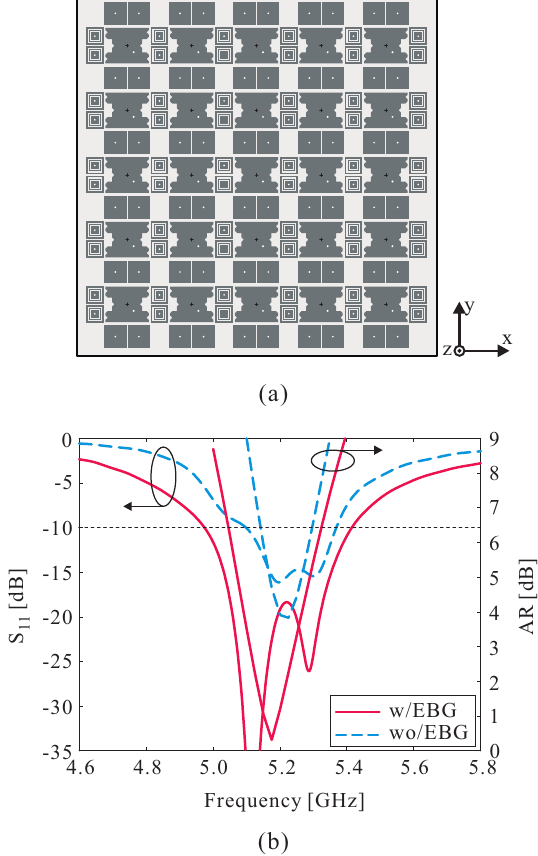
Figure 7. ( a ) 5 × 5 CP Koch-shaped patch array with the EBGs; ( b ) Simulated results of the reflection coefficients and